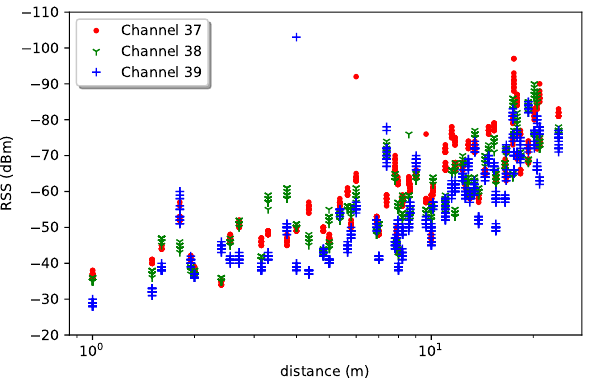
Figure 13. Scatter plot of all RSS measurement data that are collected from one of the six receivers.